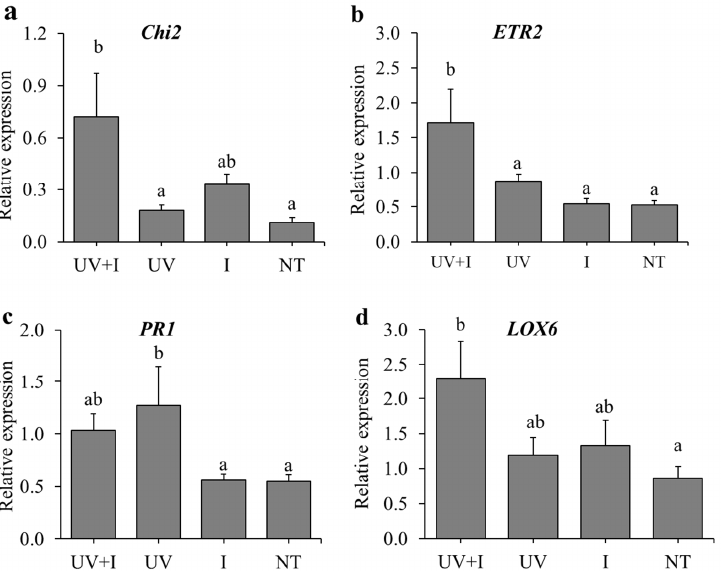
Figure 5. Relative expression levels of Chi2 , ETR2 , PR1, and LOX6 in cucumber leaves after treat ‐ ment with UV ‐ B, powdery mildew inoculation, or combined UV ‐ B + powdery mildew inoculation. a: Chi2 , b: ETR2 , c: PR1 , d: LOX6 . NT: no UV ‐ B irradiation; UV: UV ‐ B irradiation; I: powdery mildew inoculation; UV+I: UV ‐ B irradiation followed by powdery mildew inoculation 24 h after UV treat ‐ ment. Different letters above columns indicate a significant difference between treatments. Vertical bars represent the standard error of the mean ( n = 6; Tukey’s test, p < 0.05). The transcript levels of each gene are normalized to Act expression. UV ‐ B irradiation did not upregulate HSP70 (a heat shock protein) or HSFA2 and HSFB2 (heat shock transcriptional factors); however, inoculation with powdery mildew